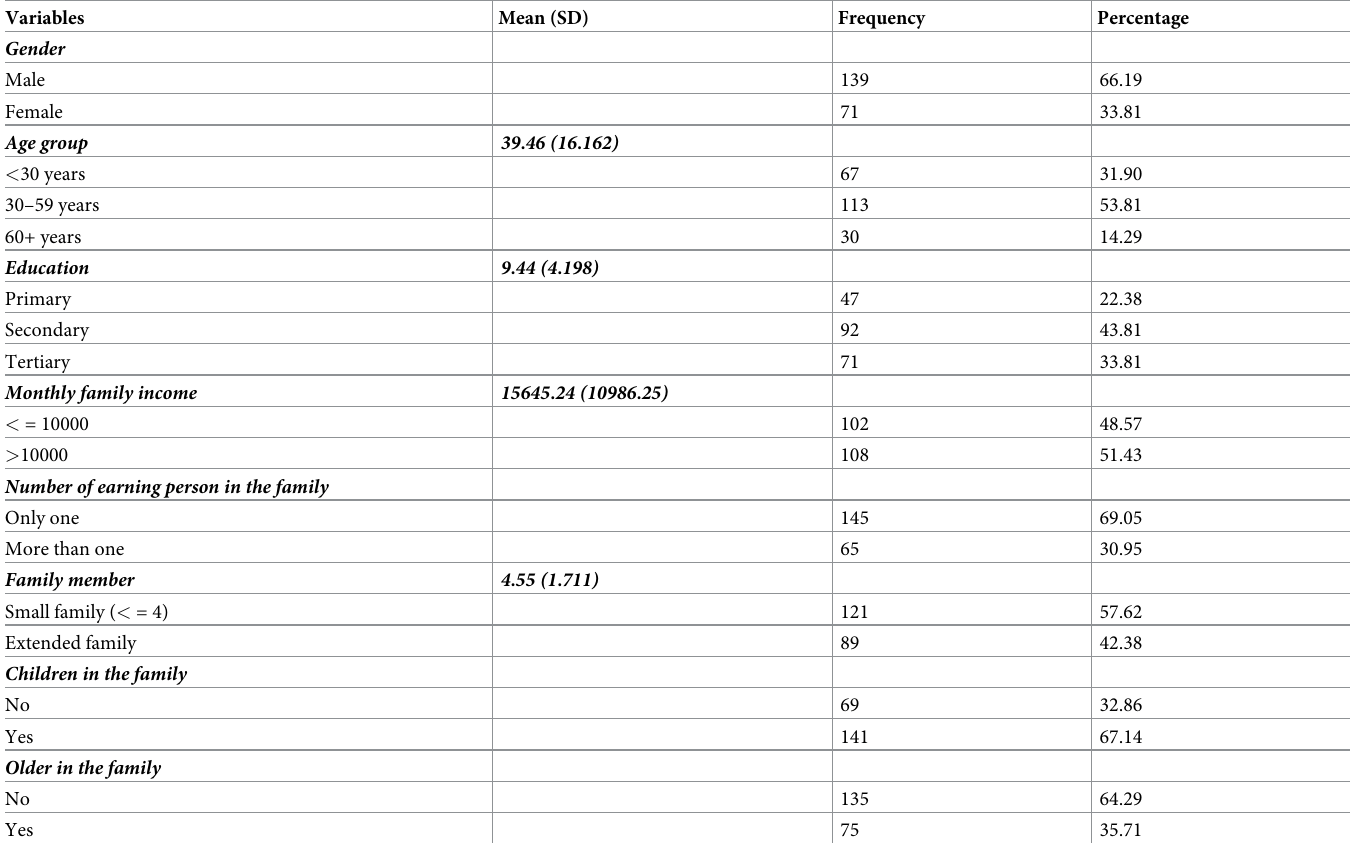
Table 1. Household characteristics of the study population Satkhira district- Bangladesh,